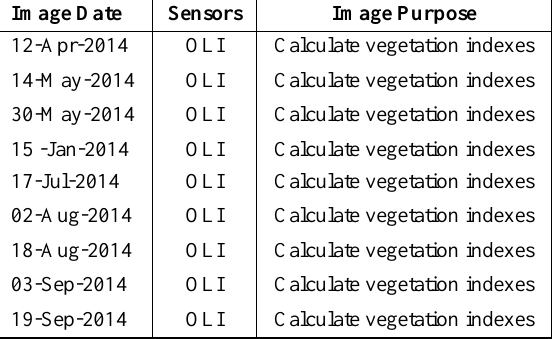
Table 1 . Nine series of Landsat